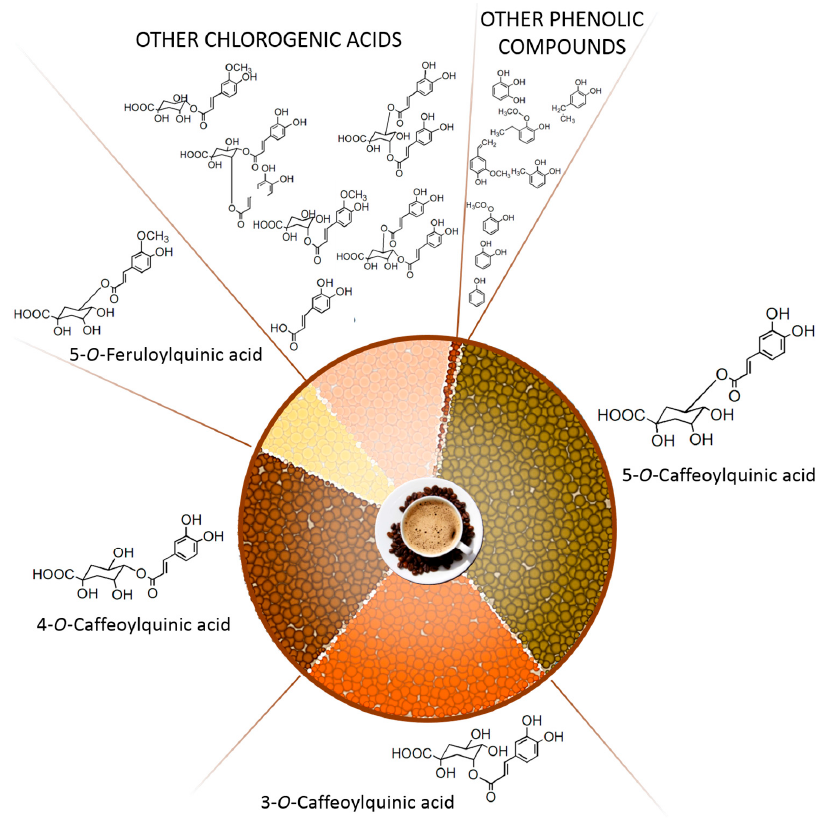
Figure 1. Phenolic compounds present in coffee.